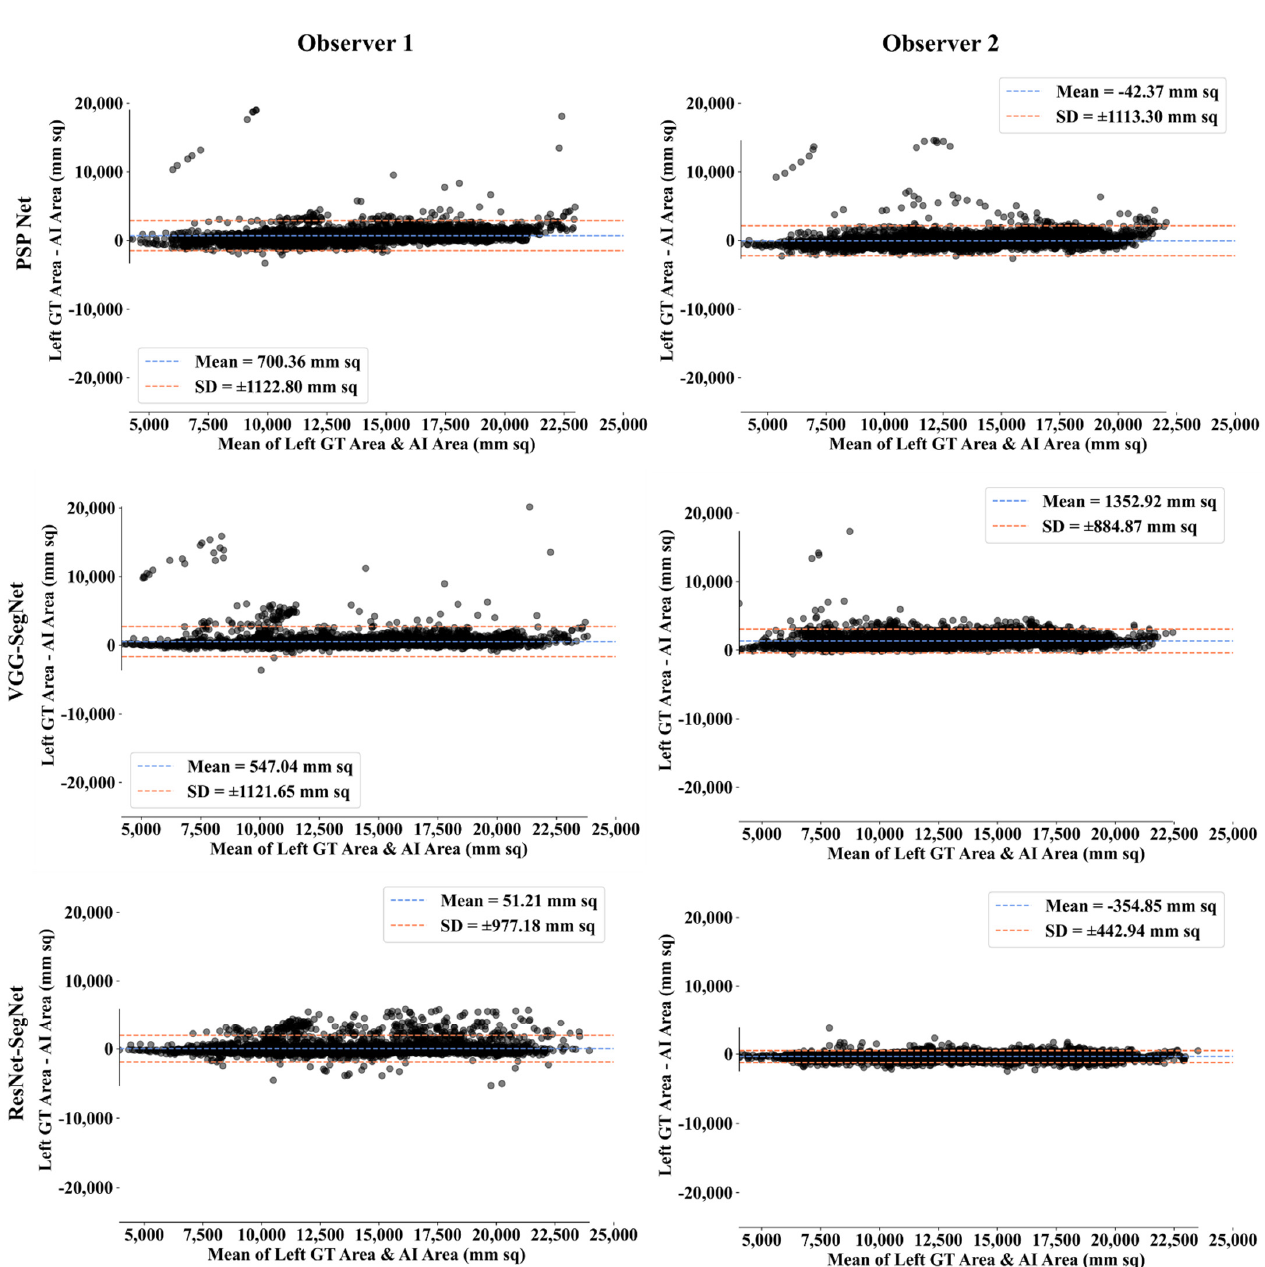
Figure 18. BA for left LA for three AI models: Observer 1 vs. Observer 2.